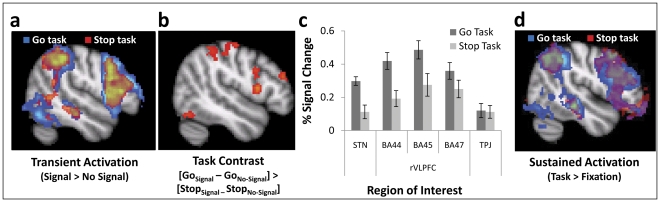
The Stop and Go tasks recruit overlapping neural substrates as revealed in both transient and sustained hemodynamics.Hybrid fMRI analyses revealed overlapping neural activity in the Stop and (Double) Go Tasks (A), with significantly more rVLPFC activity in the Go Task (B). ROI analyses for the contrast of Signal vs. No-Signal trials (C) revealed increased activity in the Go Task throughout a putatively stopping-specific network; this pattern did not generalize to regions with more general attentional functions (e.g., TPJ). Sustained rVLPFC activity was also observed across all trials within each task (D).